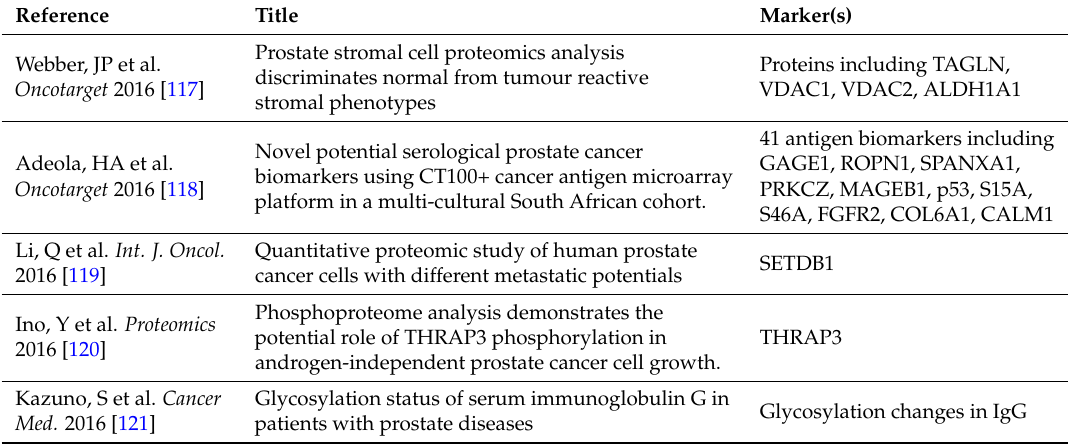
Figure 2. PubMed Search Results for Proteomics and Prostate Cancer: A PubMed search was conducted in March 2016 with the search terms “Prostate Cancer” AND “Proteomics”. The total number of ‘hits’ was 533, with dramatic increases observed for the years 2003 and 2013. Table 3. Selected Publications Related to Prostate Cancer and Proteomics research over the last ten years.